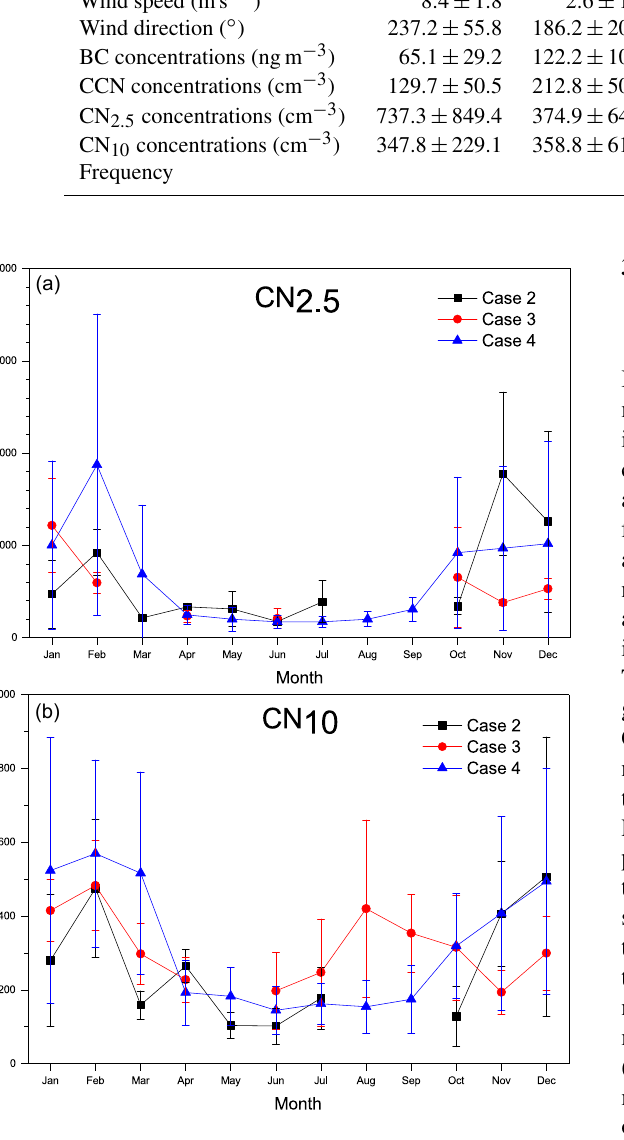
Figure 13. Seasonal variation in mean (a) CN 2 . 5 and (b) CN 10 con- centrations with a standard deviation depending on the air mass ori- gin. The error bars represent the standard deviation of the measure- ments from the mean